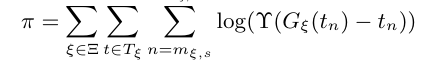
(b) Lane accurate graph of the intersection model of Fig. 3c